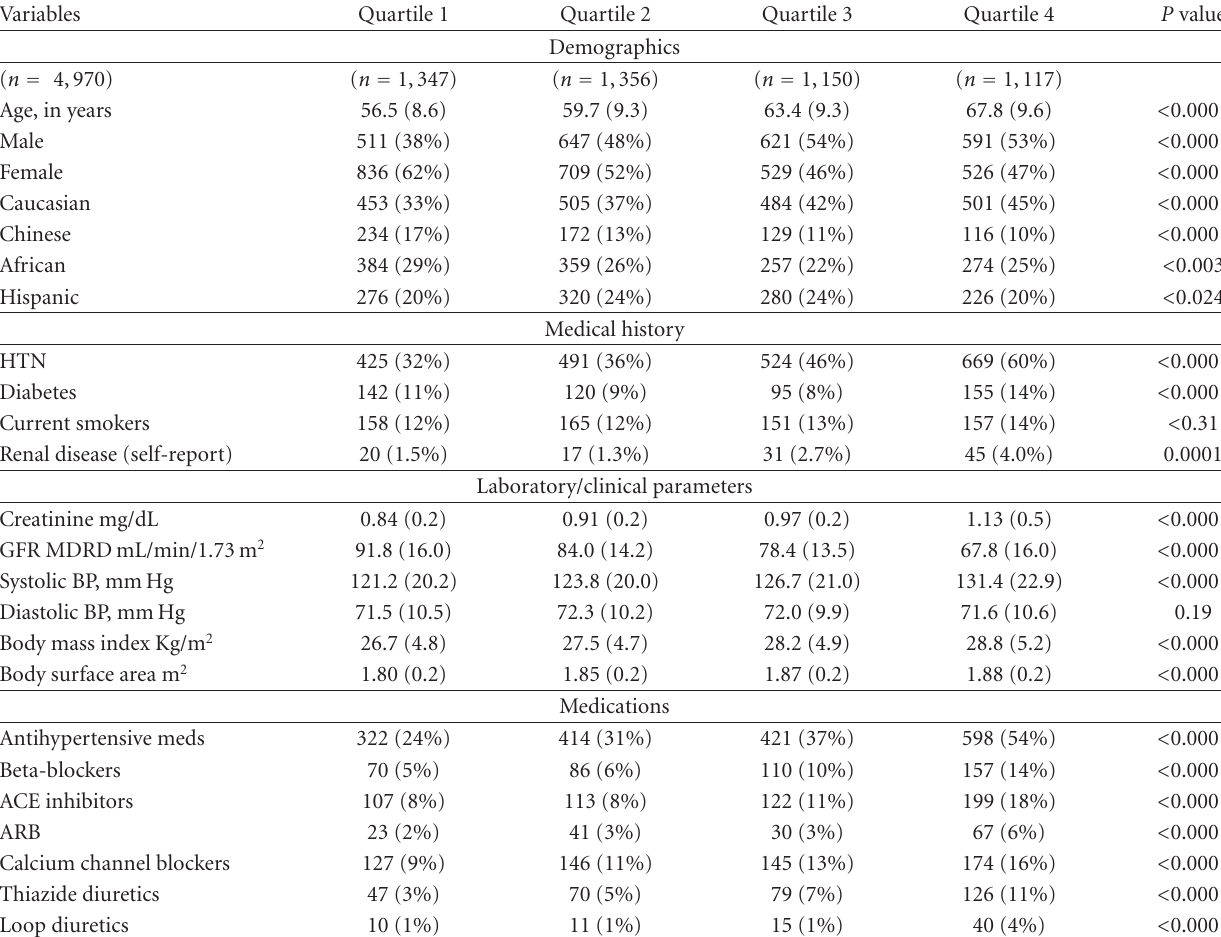
Table 1: Baseline characteristics of 4,970 MESA participants by quartile of cystatin